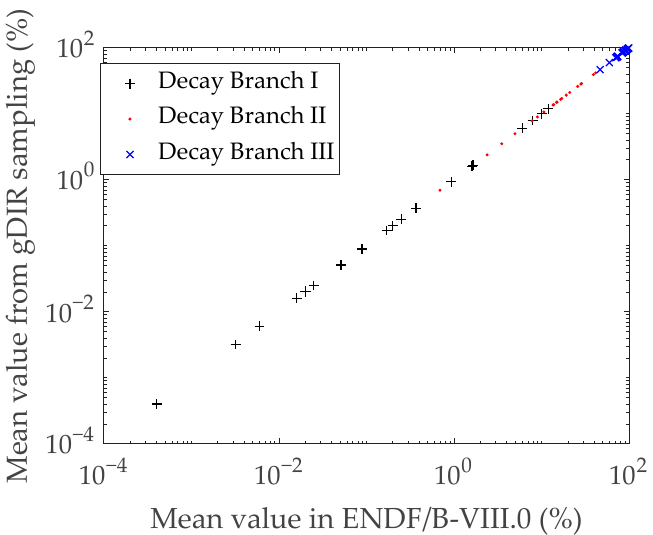
Figure 6. Comparison between suggested mean values in ENDF/B-VIII.0 and estimated mean values from DIR sampling method. (Black “+”, red “.”, and blue “×” are decay branches I, II, and III, re- spectively).